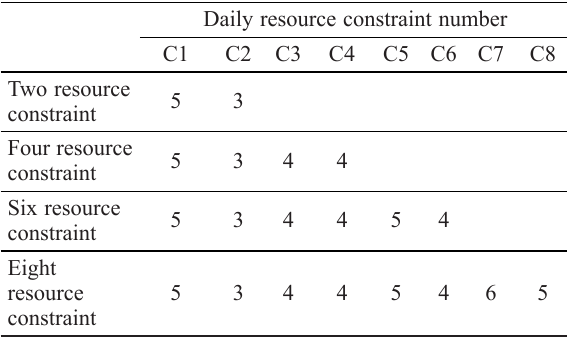
Table 2. Daily resource constraint (C) number